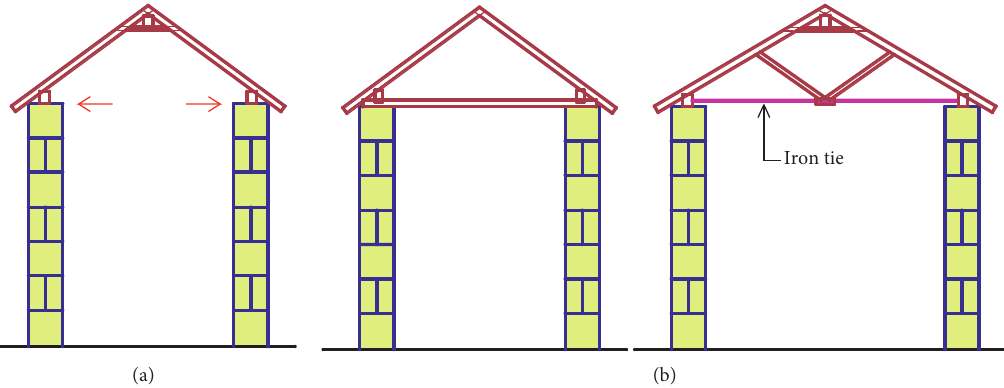
Figure 6: Some schemes of the wooden roofs of historical buildings. (a) Unfavourable. (b) Favourable.